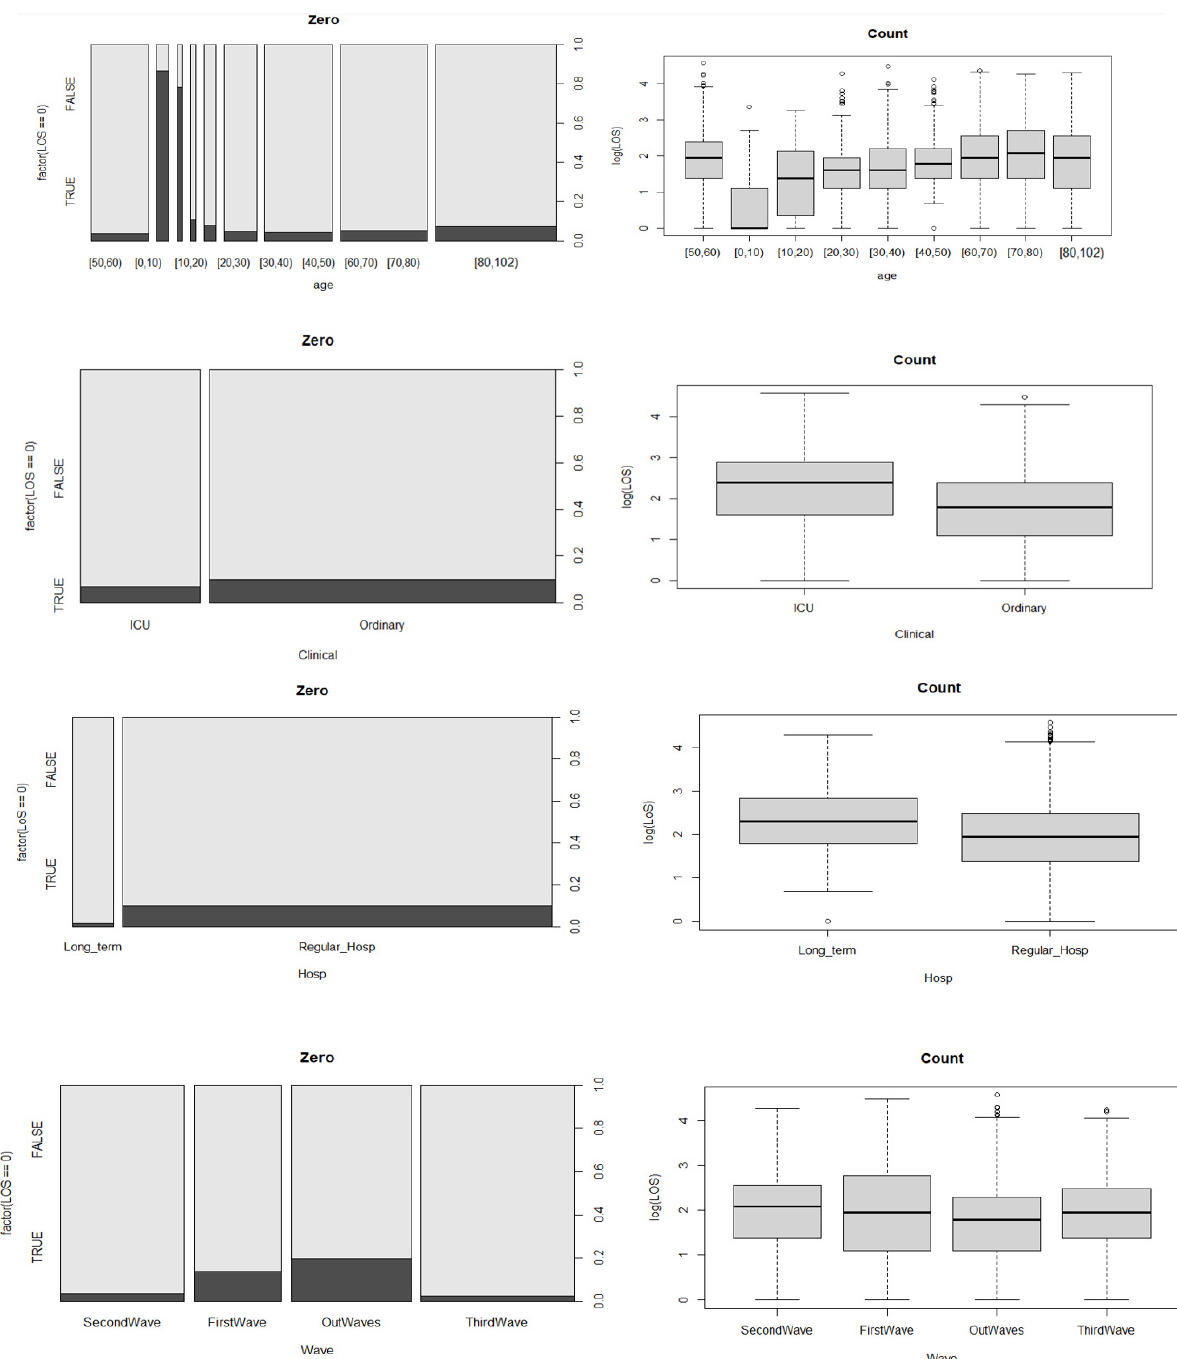
Figure 3. LoS plotted against the predictors used. All plots show the variation in LoS when the predictors were changed.